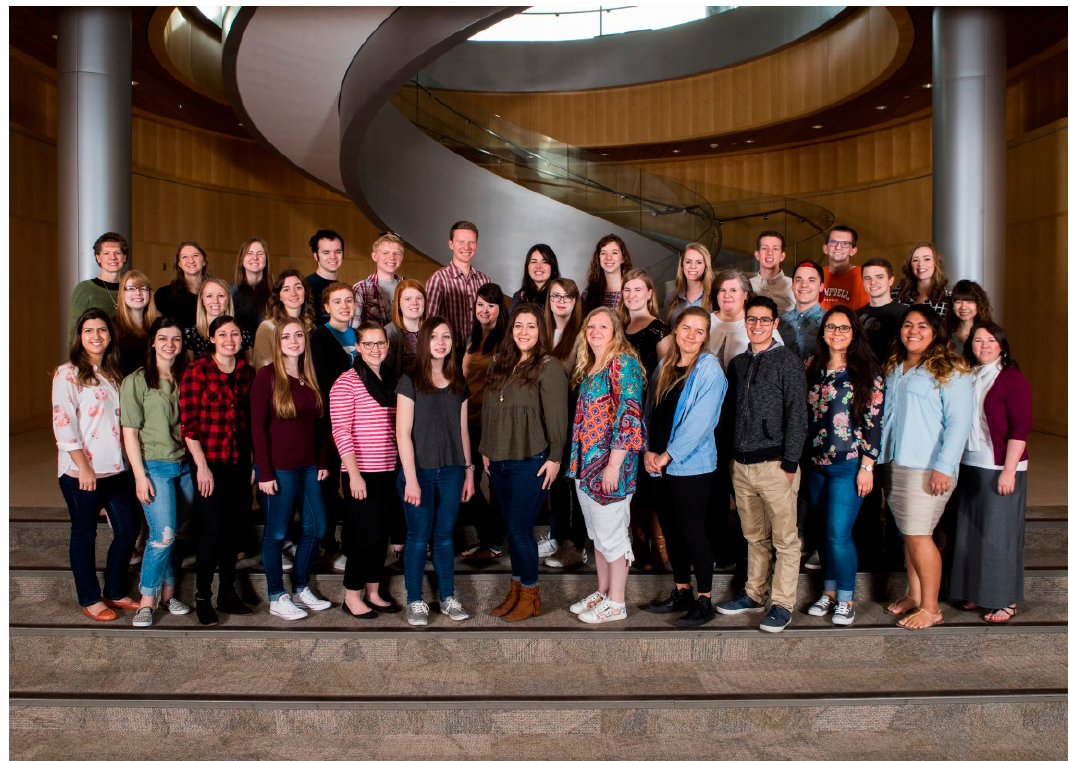
Figure 1. Researchers at the Brigham Young University (BYU) Center for Family History and Genealogy.